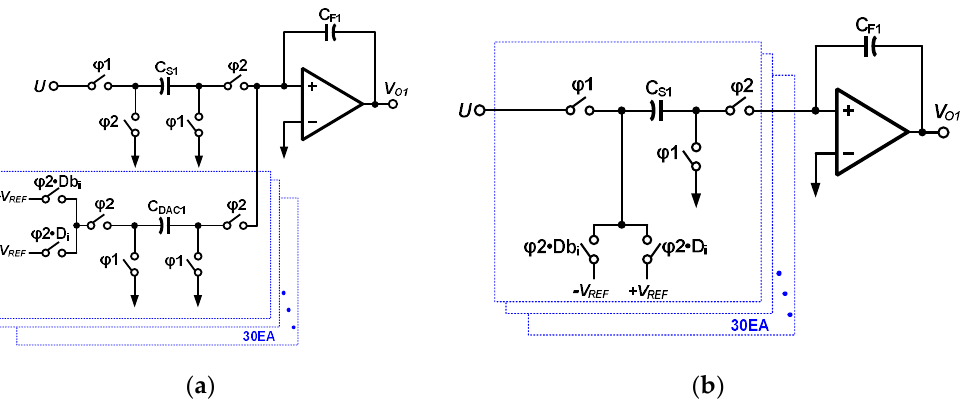
Figure 10. Switched capacitor implementation of input branch ( a ) for prototype A and ( b ) for prototype B.